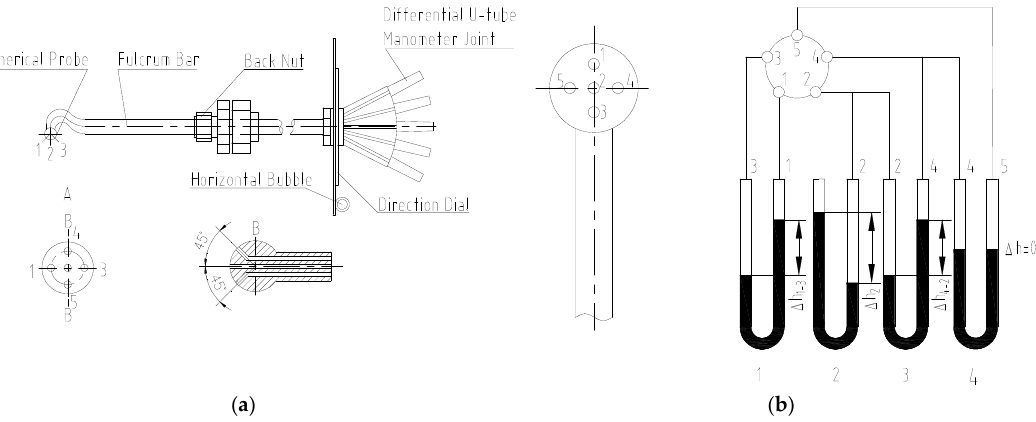
Figure 12. Probe measuring system. ( a ) Structure diagram of the five-hole spherical probe; ( b ) Connection system diagram of five-hole spherical probe and differential pressure meter.